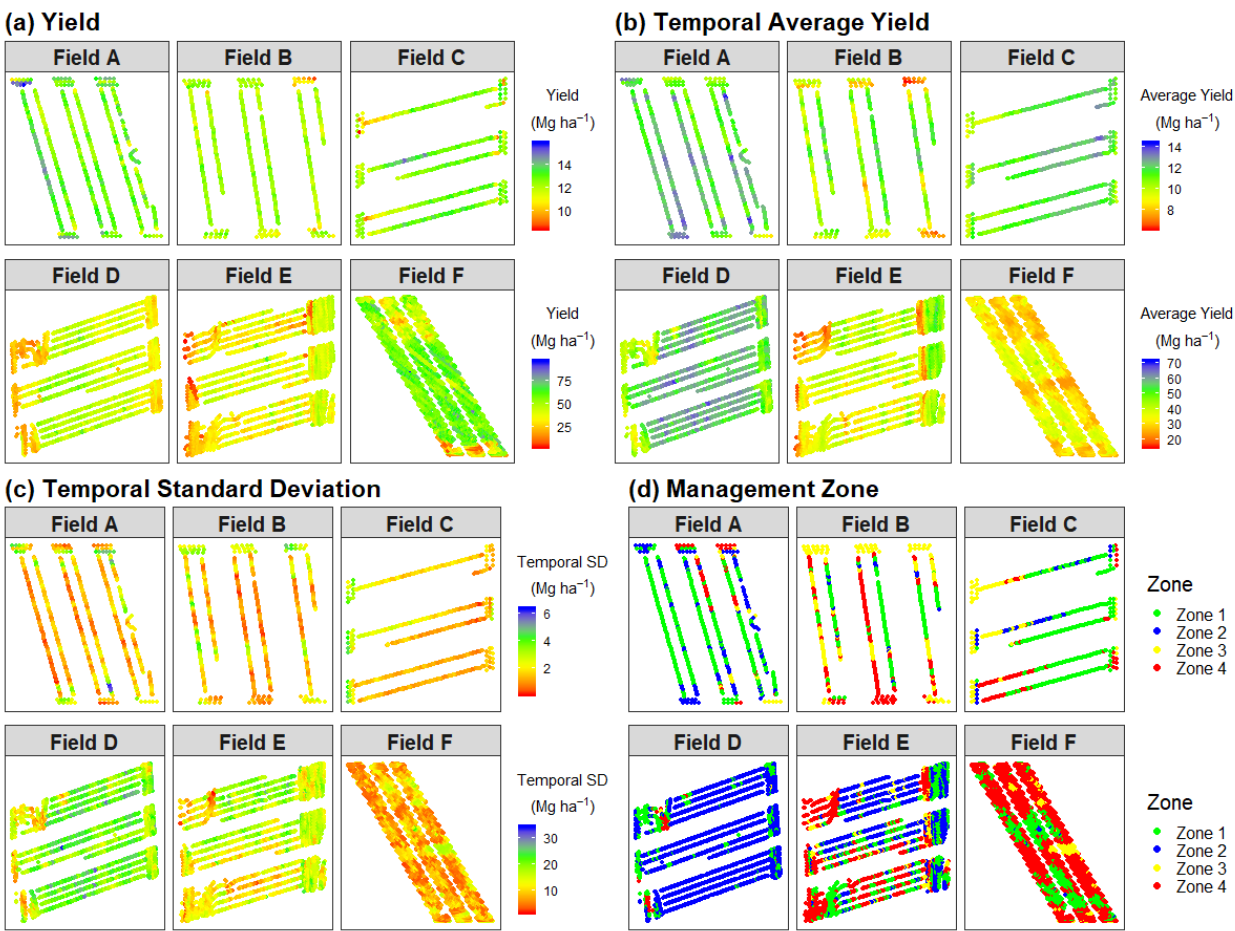
Figure 5. Spatial distribution of yield ( a ), historic average yield ( b ), temporal standard deviation ( c ), and management zones ( d ), as estimated based on previous years of yield produced for six fields (A through F). Yield stability management zones were delineated as described in Kharel et al. [15]. Zone 1 represents high-yielding-stable, Zone 2 represents high-